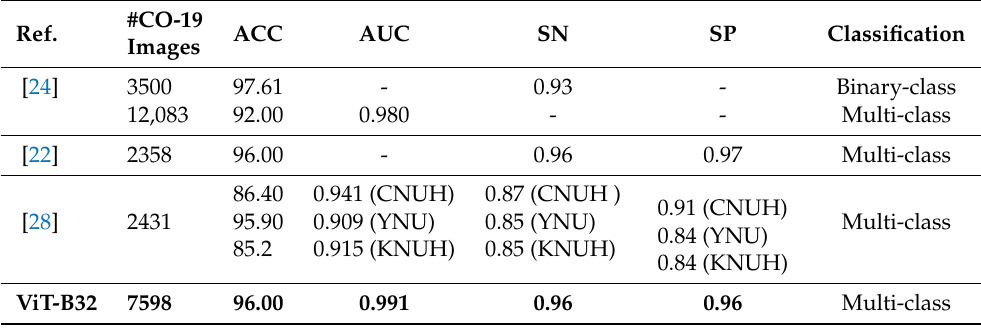
Table 5. Performance comparison with state-of-the-art methods using Vision Transformers for COVID-19